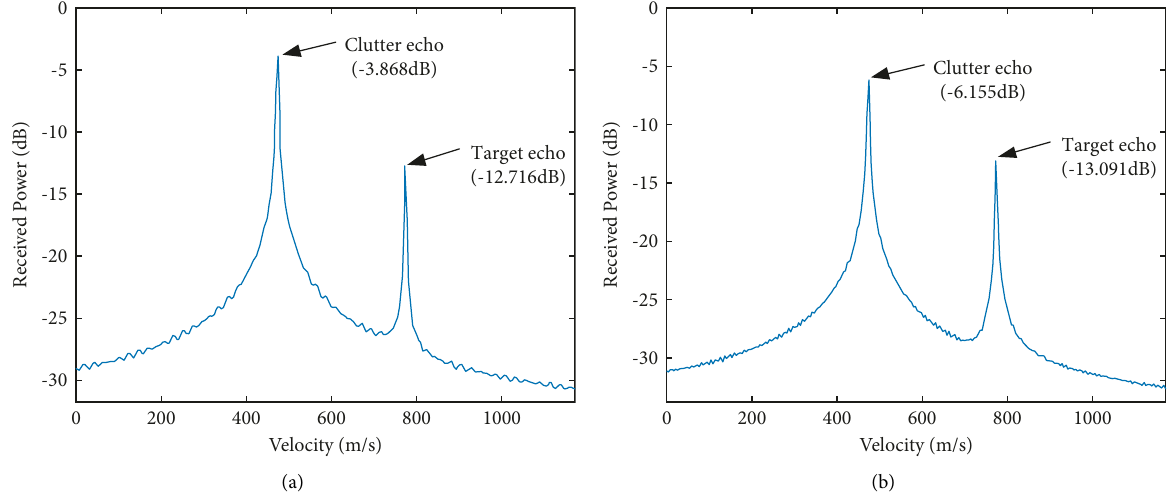
Figure 13: The echo power of target and clutter under different bandwidths (a) B � 5M Hz; (b) 10M